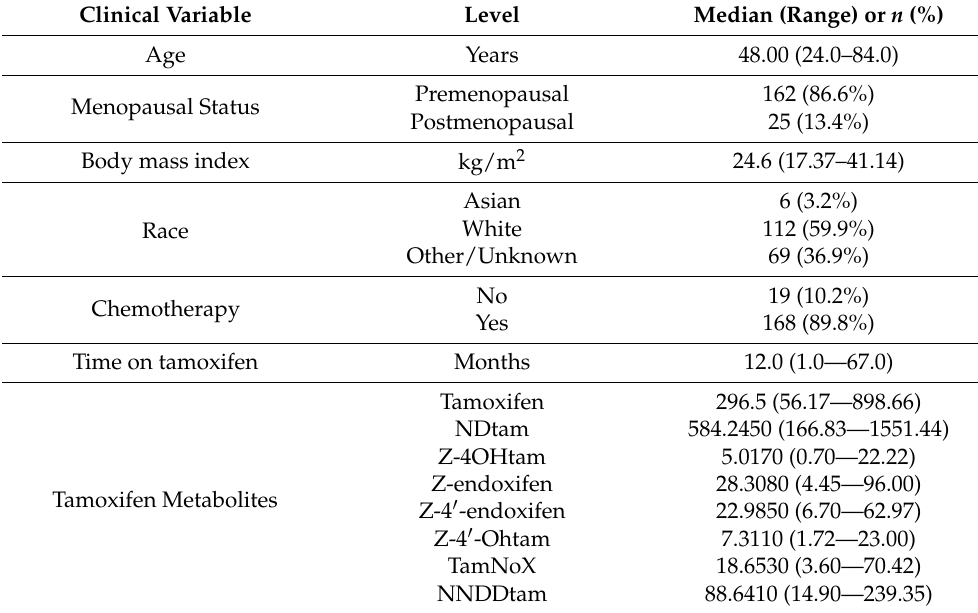
Table 1. Patient Demographics.